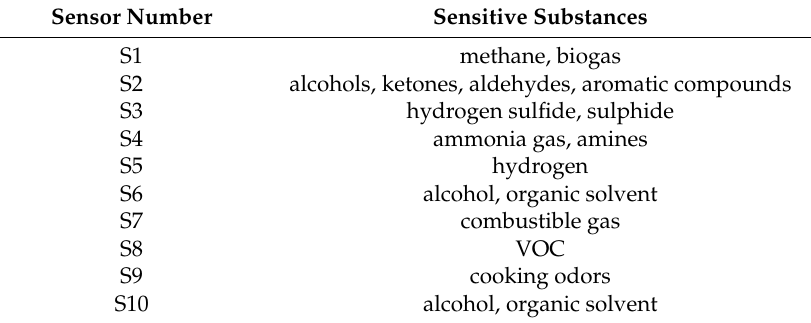
Figure 2. ( a ) The schematic of the electronic nose and ( b ) a photo of the sensor array. Table 1. Gas sensor array and its properties.